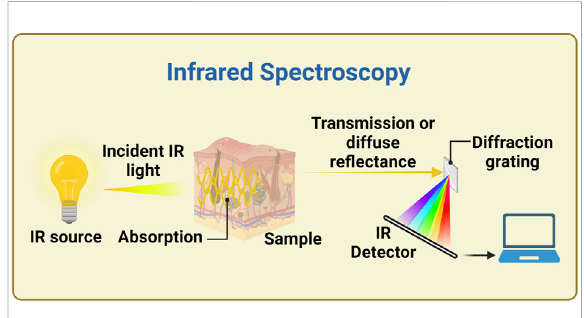
FIGURE 2 Example of experimental setup for infrared spectroscopy. A continuous IR source generates light over a wide range of infrared wavelengths, which irradiates the sample. The light is collected in transmission or diffuse re fl ectance mode, and the spectrum is measured thanks to a diffraction grating, in this example. Alternative con fi gurations use a Fourier transform interferometer (FTIR) instead of the dispersive element, or use a monochromator or other methods for selecting the wavelength bands between IR source and sample. Created with